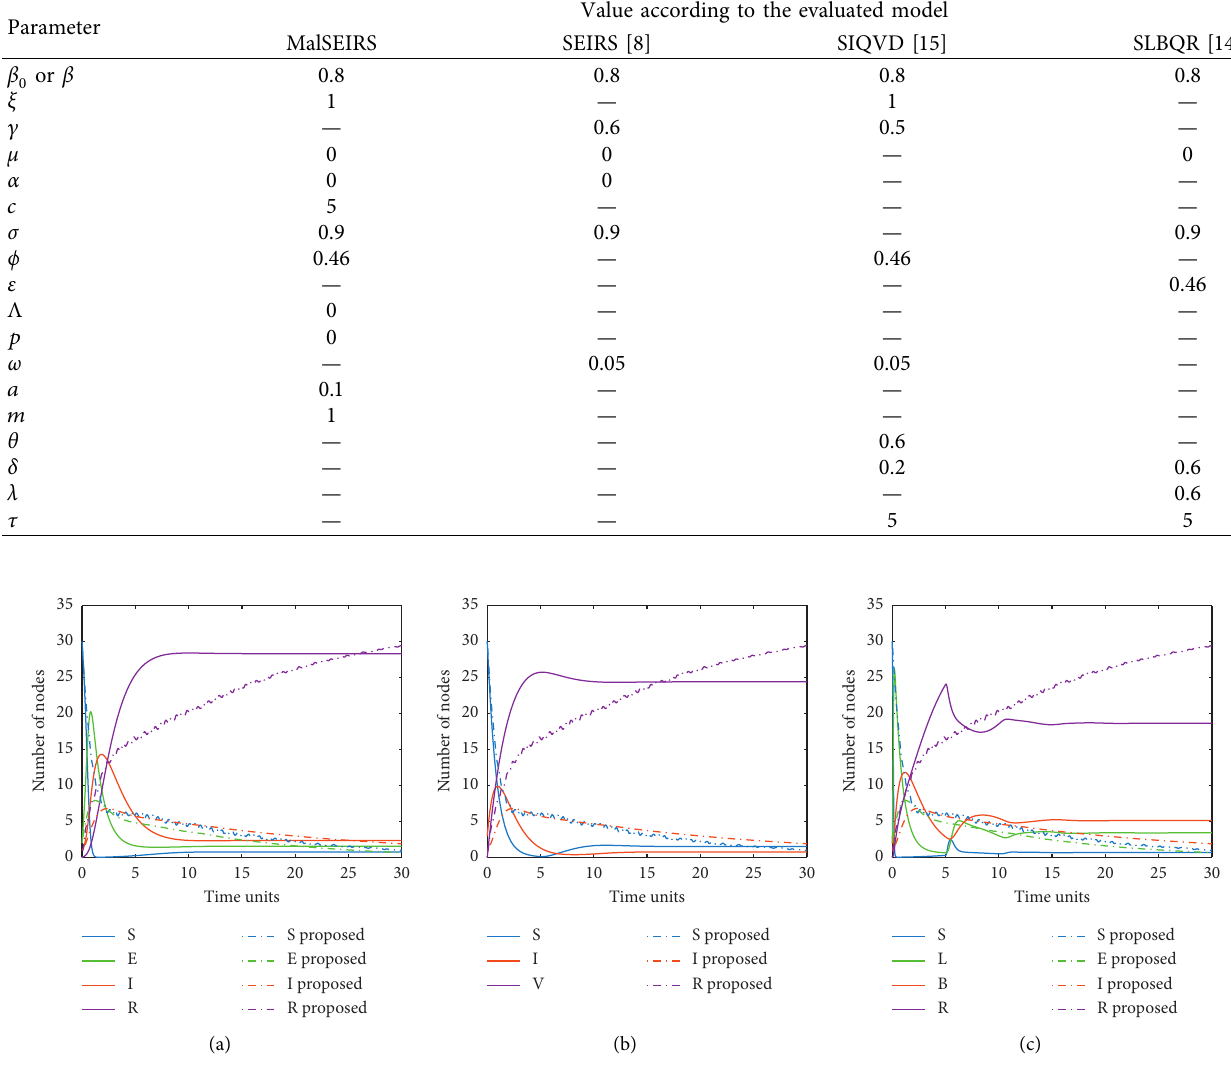
Table 4: Values selected for different parameters used in the comparative evaluation of MalSEIRS. Parameter